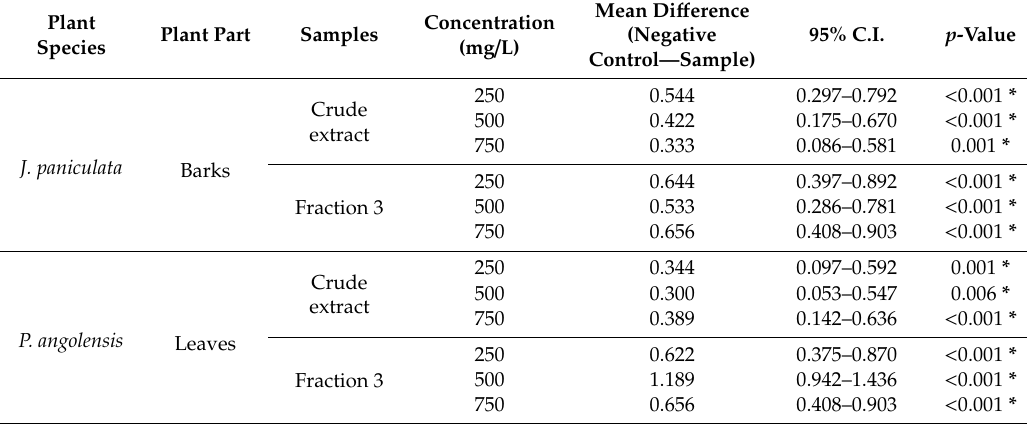
Table 8. Calculated mean di ff erence between the distance of the injury of the negative control and the